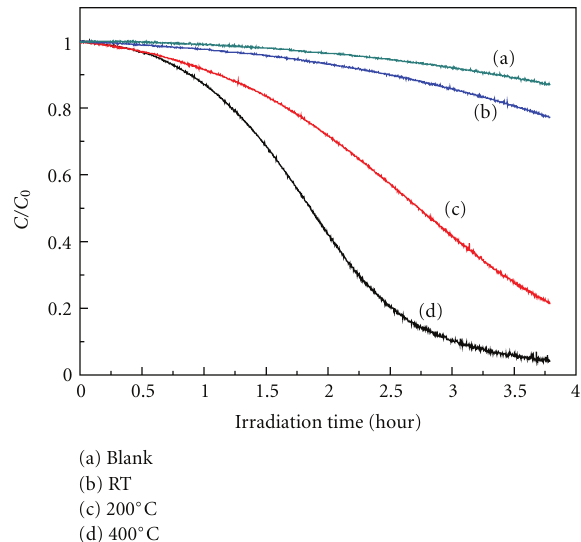
Figure 5: Decomposition rate with time of MO using N-doped TiO 2 films prepared at di ff erent temperature under visible light irradiation, (a) without TiO 2 , (b) RT, (c) 200 ◦ C, (d) 400 ◦ C. C 0 is the initial concentration of Methyl orange about 2mg / L, and C is the concentration changing with